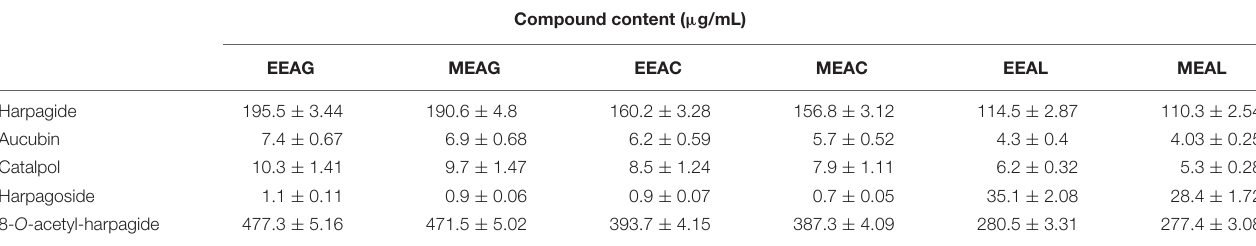
TABLE 3 | Iridoid profile of A. genevensis (AG), A. chamaepitys (AC), and A. laxmannii (AL) extracts.